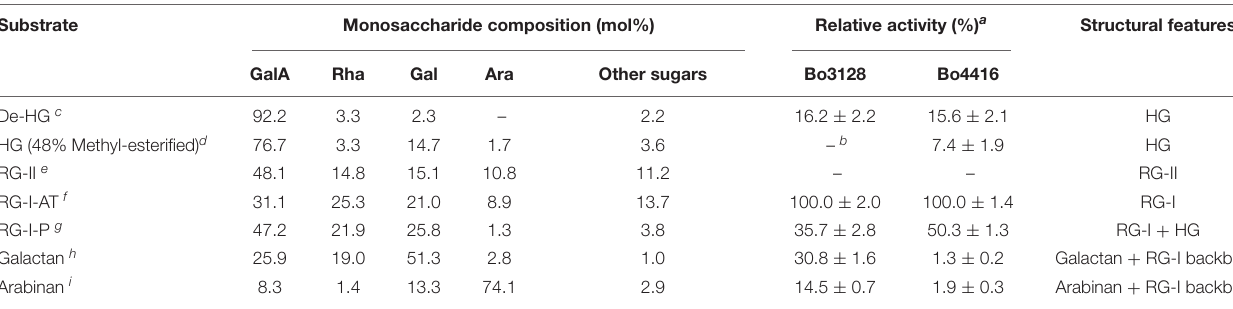
TABLE 2 | Substrate specificity of Bo3128 and